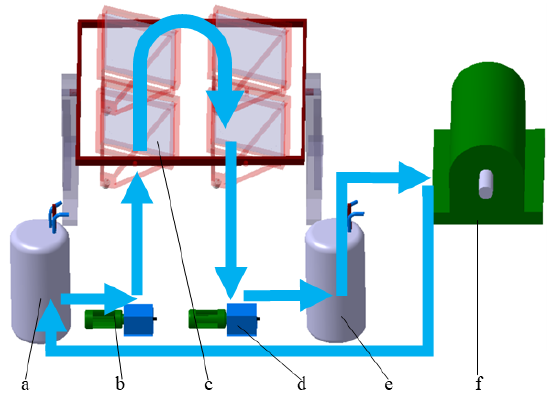
Figure 4. CSP system scheme: ( a ) normal pressure storage; ( b ) initial pump; ( c ) collector system; ( d ) high temperature pump; ( e ) high temperature/pressure storage; ( f ) turbine (and generator).